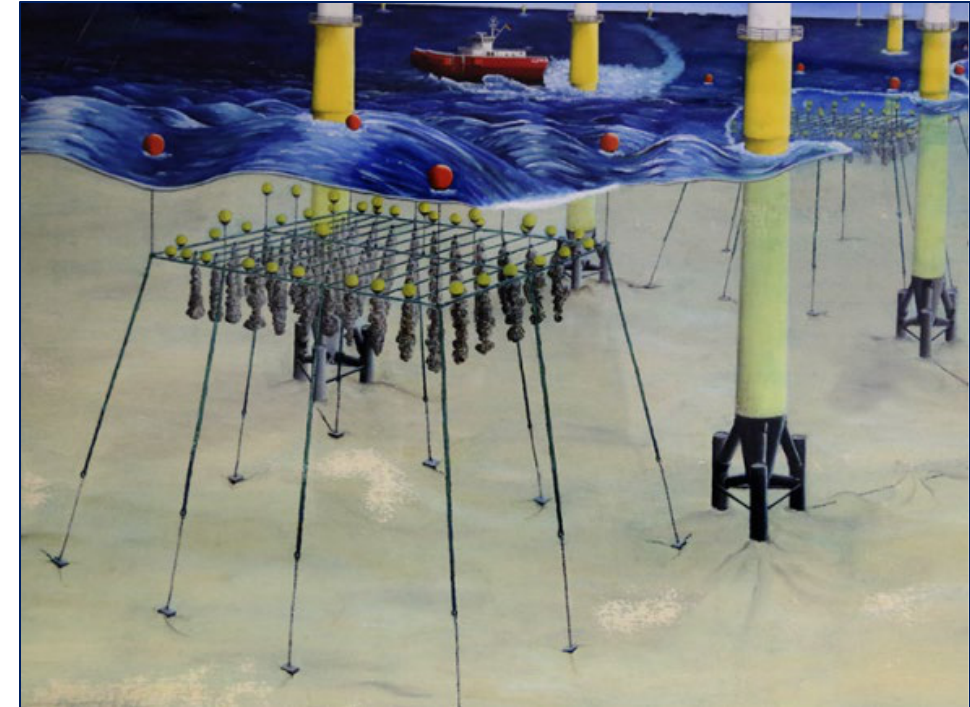
Figure 25. Cable tethered seaweed/IMTA–tensile system in offshore wind park [13].